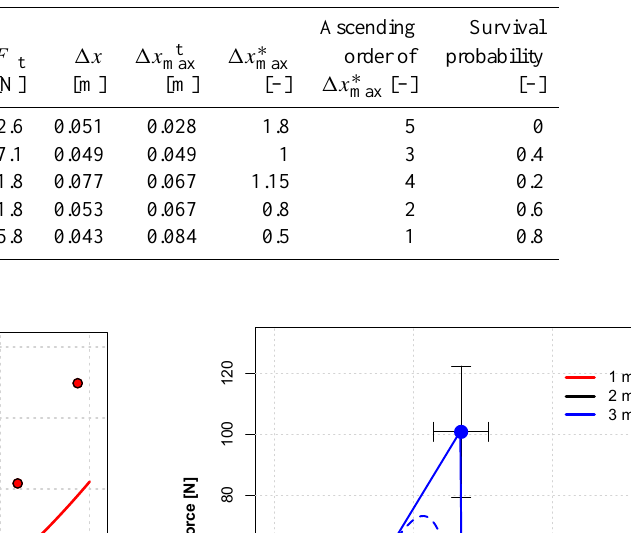
Table 1. Summary of computed values used in the example of Fig. 1.